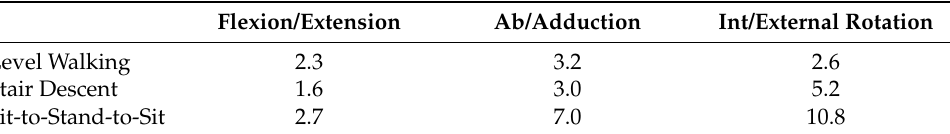
Table 2. Maximum absolute errors (in degrees) between sensor-estimated kinematics and simulator- generated ground truth data over all subjects, for every activity type, and each of the three planes of rotation.